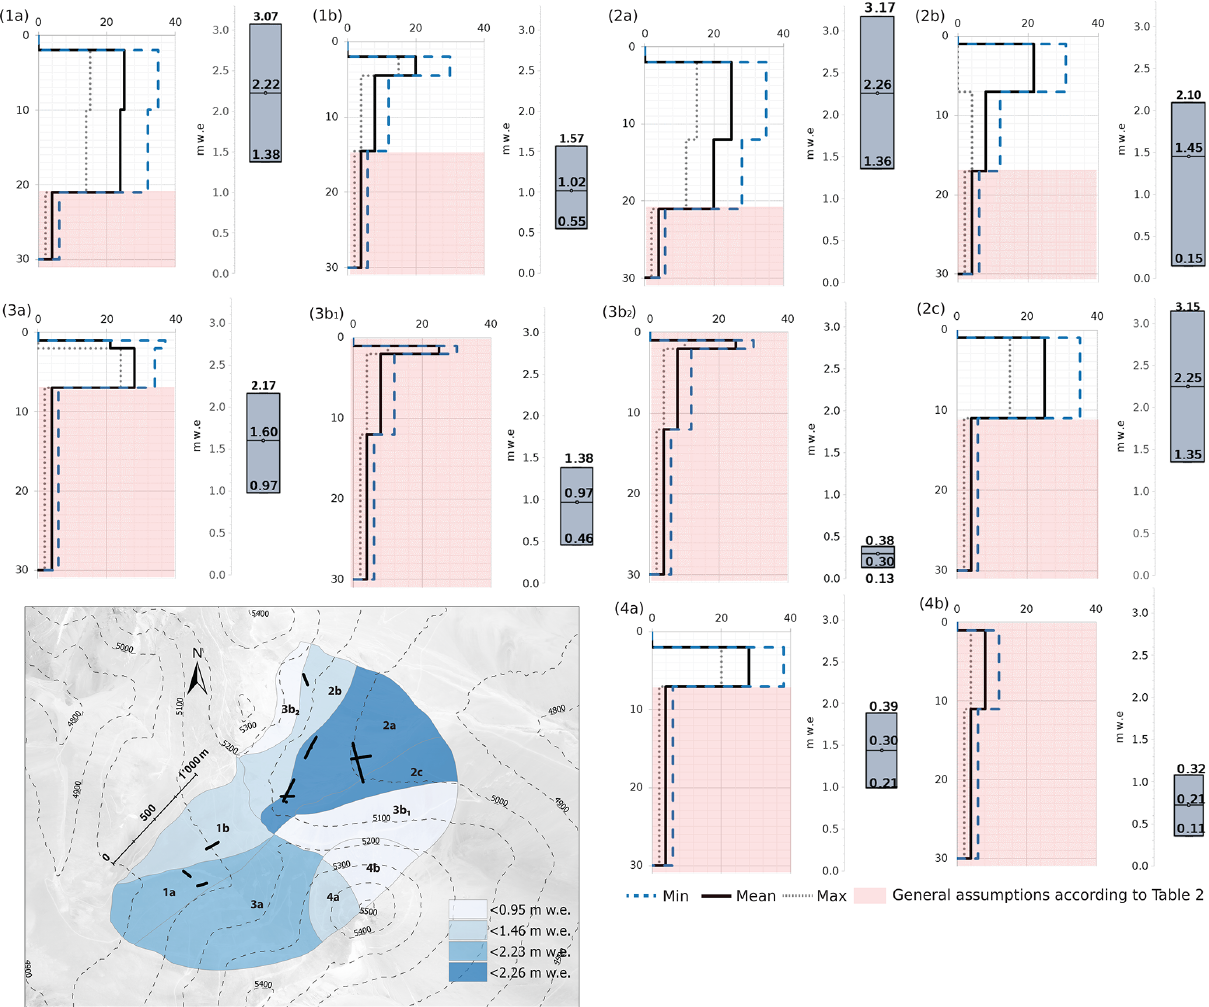
Figure 7. Assumed min, mean, and max ice content stratigraphies for all upscaling classes ( x axis = ice content (%), y axis = depth (m)), based on the geophysical results and calculated ground ice content for each upscaling class. The red shaded parts of the plots indicate where assumptions were made based on Table 2. The resulting min, mean, and max water contents for each class are shown (in mw.e.) in the boxplots. The map shows the meters of water equivalent distribution for site